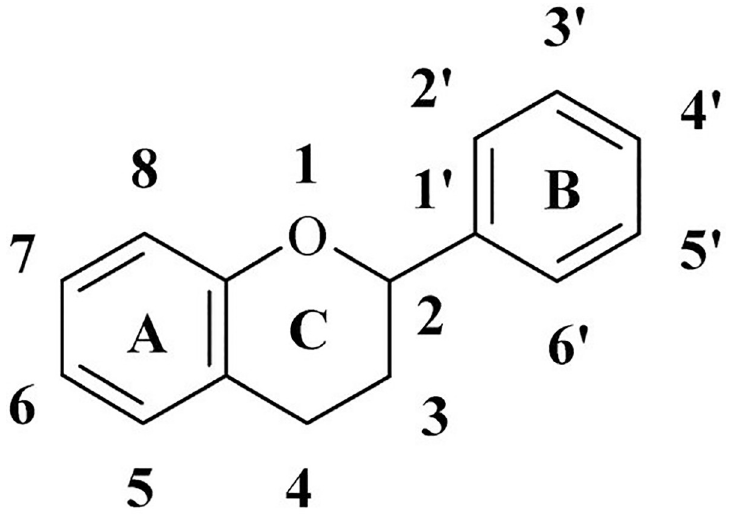
Fig 1. General flavonoid